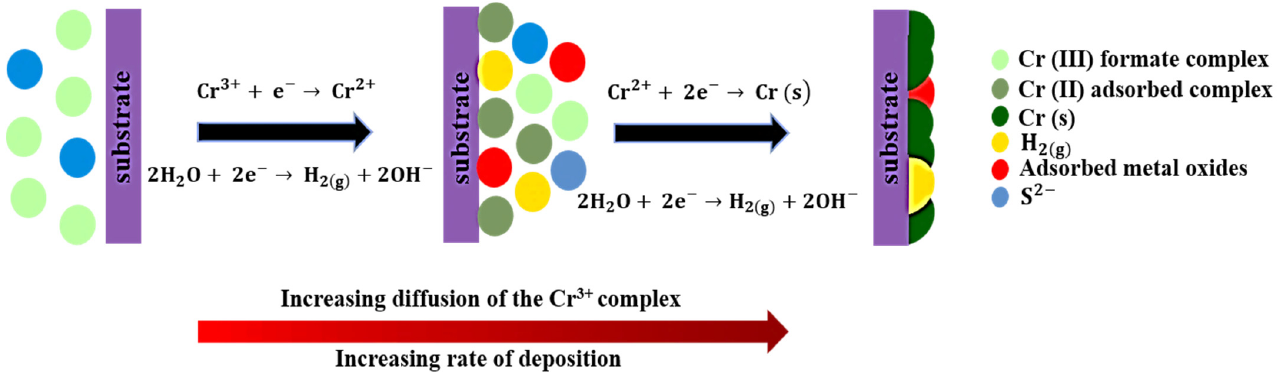
Figure 2. A schematic explanation of the mechanism of Cr electrodeposition.